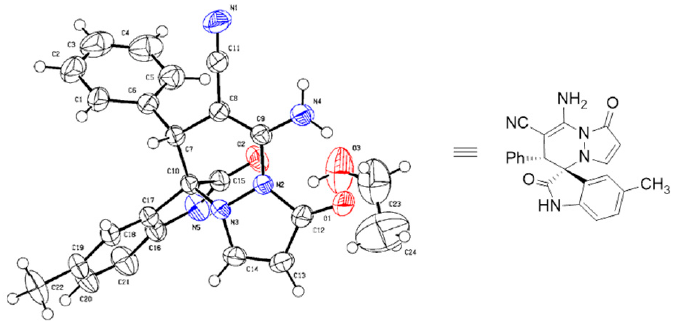
Figure 3. X-ray crystal structure of 4a (CCDC: 2151254).